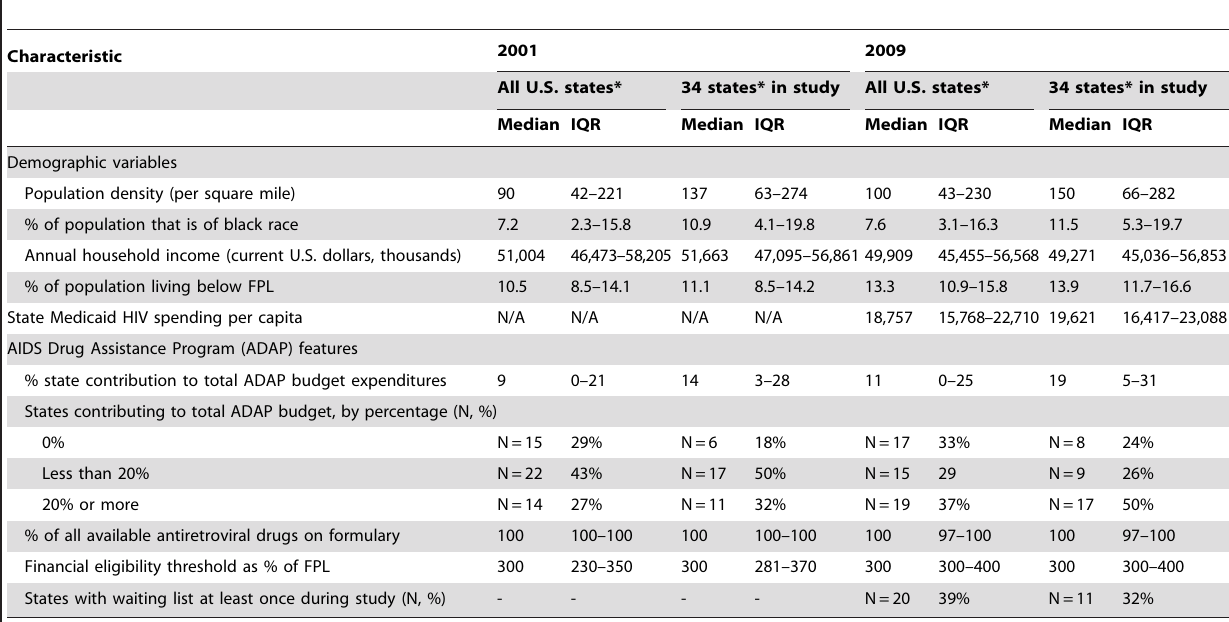
Table 1. Comparison of demographic characteristics and AIDS Drug Assistance Program features of U.S. states represented in study, 2001 and 2009